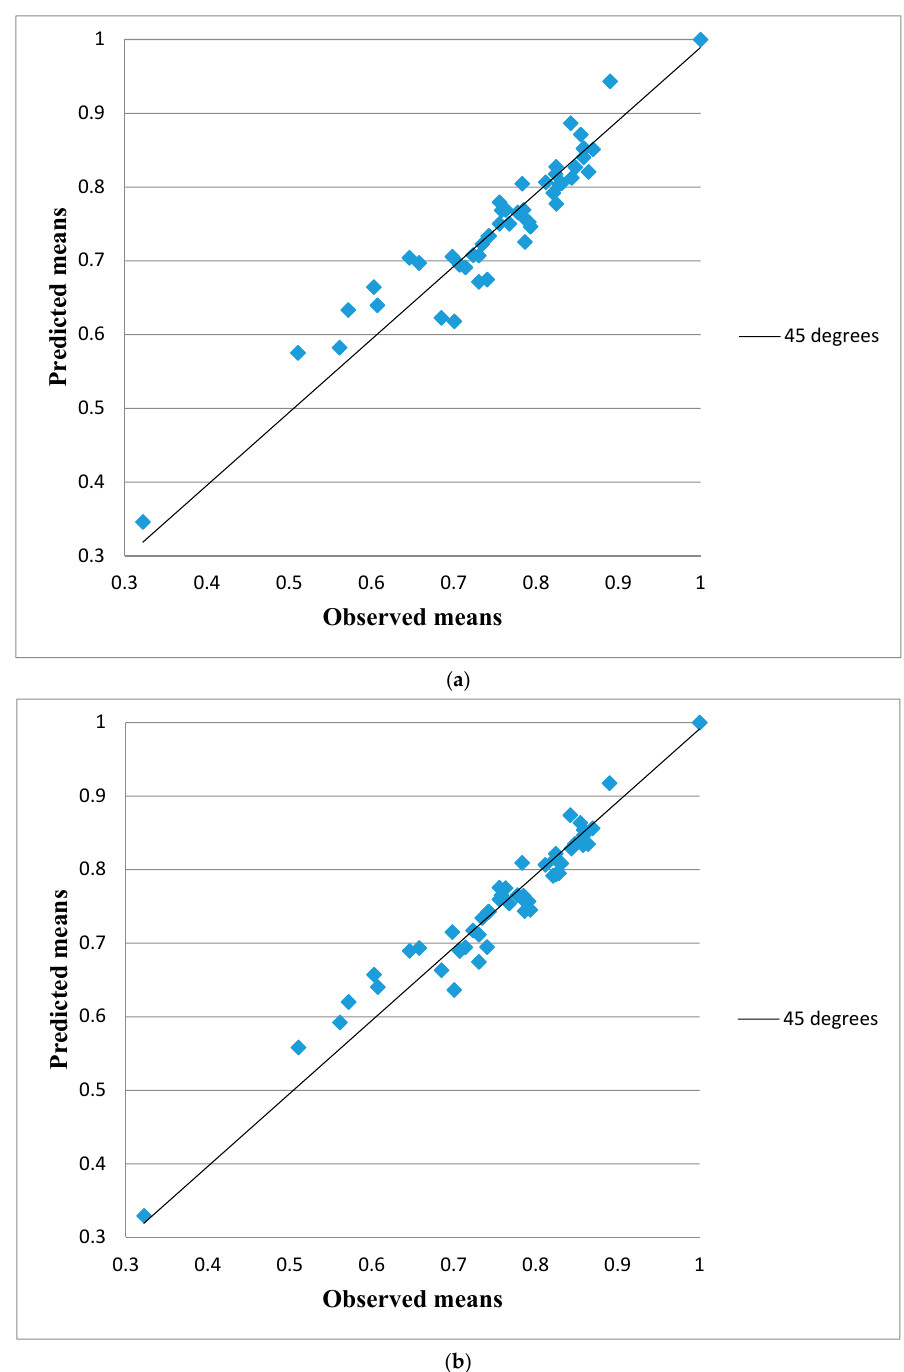
Figure 3. Actual and predicted utilities for ( a ) the crude model and ( b ) model (1).